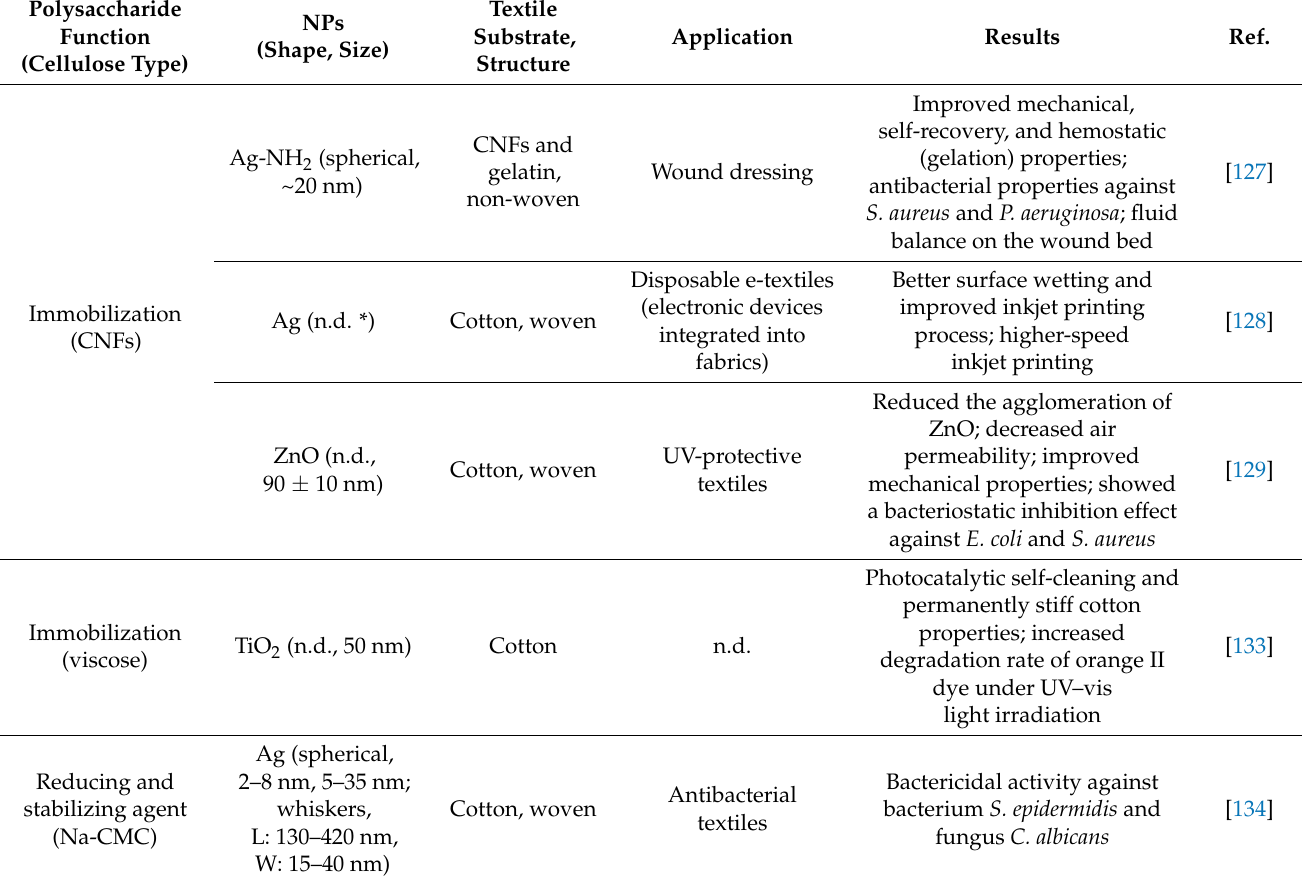
Table 5. Textile materials functionalized with cellulose and MNPs. Polysaccharide function towards